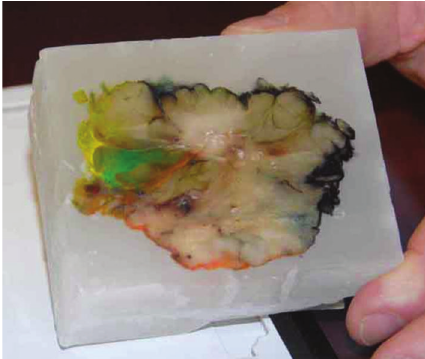
Figure 6: Para ffi n block from lumpectomy specimen marked with India ink in multiple colors for orientation of surgical margins. Note migration of ink into interior of specimen. Figure 7: Large-format section of a lumpectomy specimen with